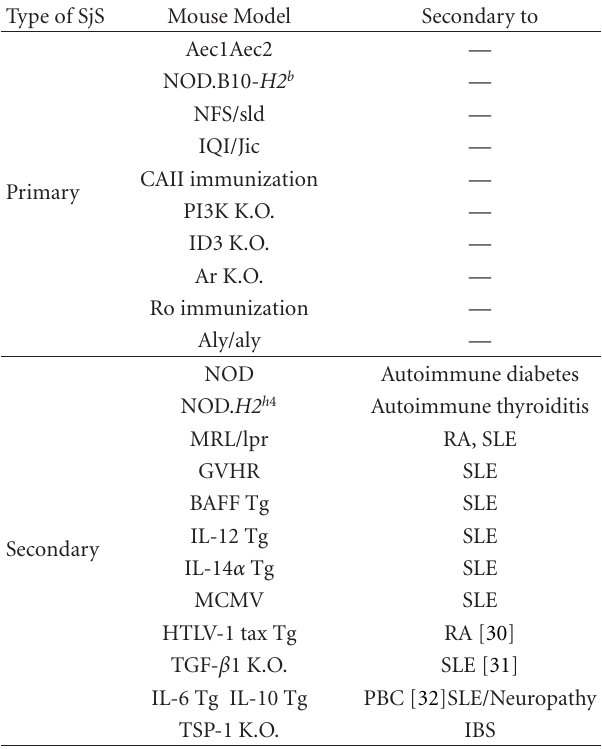
Table 2: Primary and secondary SjS mouse